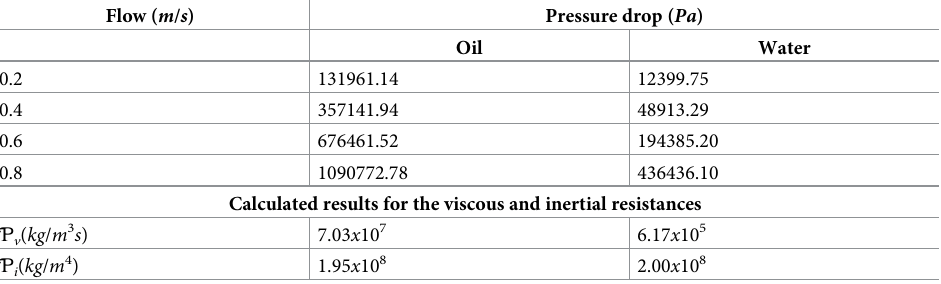
Table 4. Results for the calculation of the inertial and viscous porous resistances for the slotted